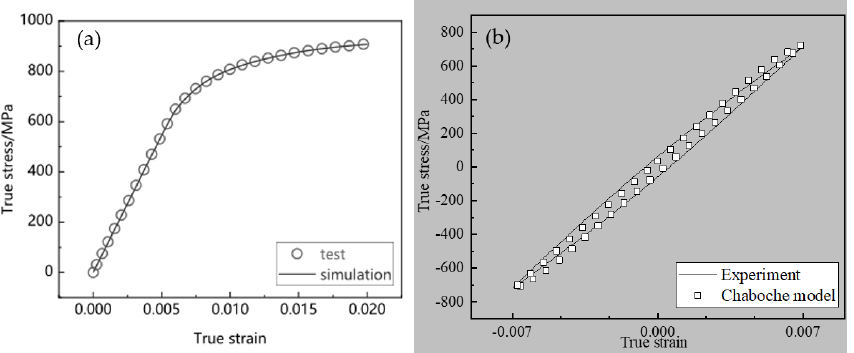
Figure 5. Simulation, ( a ) and experimental results of uniaxial tension and LCF steady-state hysteresis loop at 1.4% strain range, ( b ).